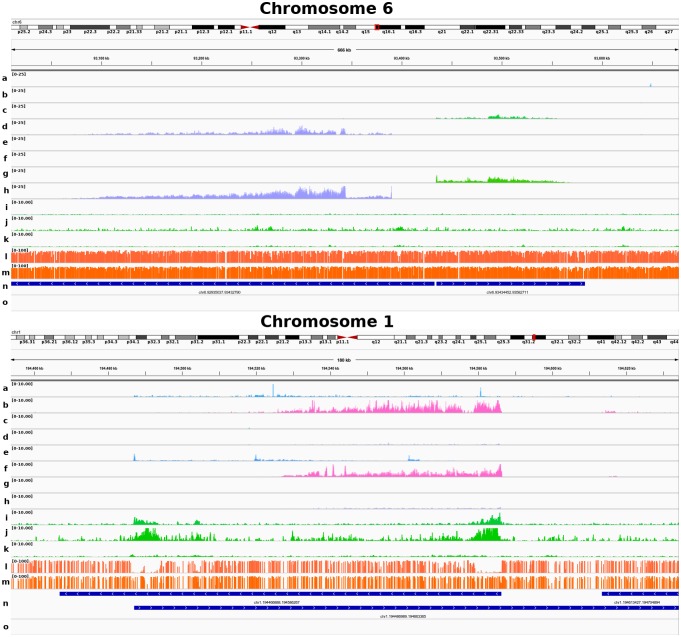
Genome wide tracks of gene expression, active histone marks and CpG methylation of subtype-specific cALL vlincRNAs.Epigenetic tracks of vlincRNAs expressed in specific subtypes. Top, HHD-specific vlincRNAs expressed on chromosome 6 in both the SOLiD and Illumina sequencing platforms. Bottom, t(12;21)-specific vlincRNAs expressed on chromosome 1 in both the SOLiD and Illumina sequencing platforms. Splicing patterns are more clearly defined with Illumina RNA-seq data. (A,B) Normalized read coverage of t(12;21) vlincRNA expression (SOLiD platform, + and—strands). (C,D) Normalized read coverage of HHD vlincRNA expression (SOLiD platform, + and—strands). (E,F) Normalized read coverage of t(12;21) vlincRNA expression (Illumina platform, + and—strands). (G,H) Normalized read coverage of HHD expression (Illumina, + and—strands). (I,J,K) Normalized read coverage of the H3K4me3, H3K27ac and H3K4me1 ChIP-seq histone marks in the t(12;21) pool sample. (L,M) WGBS methylation levels of the merged t(12;21) cases (n = 3) and the CD10+CD19+ control cells. (n) Coordinates of vlincRNA transcripts (n = 288) found in the discovery samples (n = 68). (o) RefSeq gene annotations.